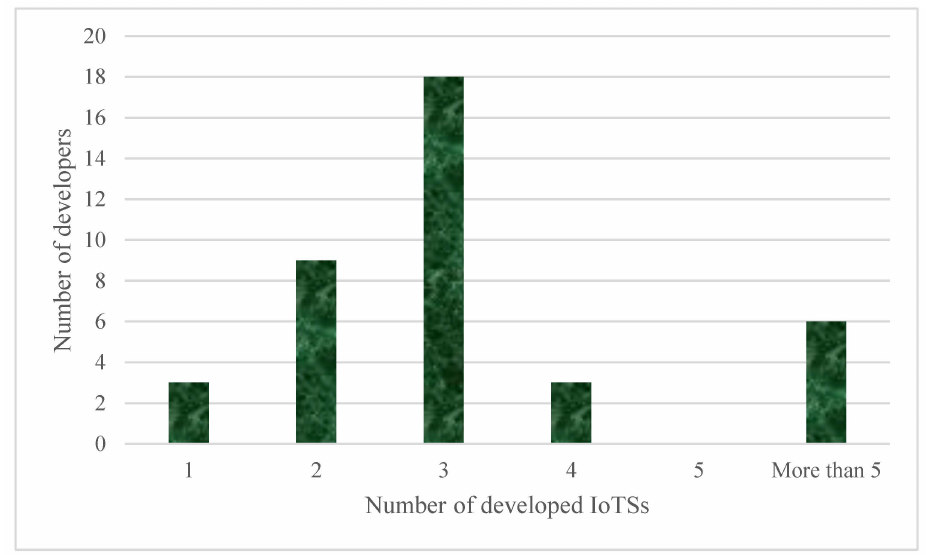
Figure 11. Respondents’ experience in the development of IoTSs.